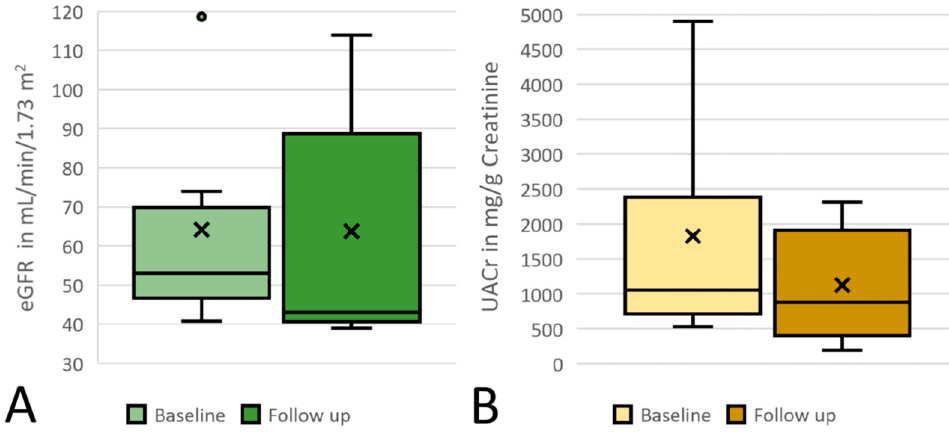
Figure 1. Proteinuria and kidney function; ( A ) eGFR at baseline and at follow-up; ( B ) UACr at baseline and at follow-up. x indicates the mean value; the circle indicates an outlier; eGFR: estimated glomerular filtration rate; UACr: urine-albumin- creatinine ratio; CKD: chronic kidney disease. × = mean; circle =